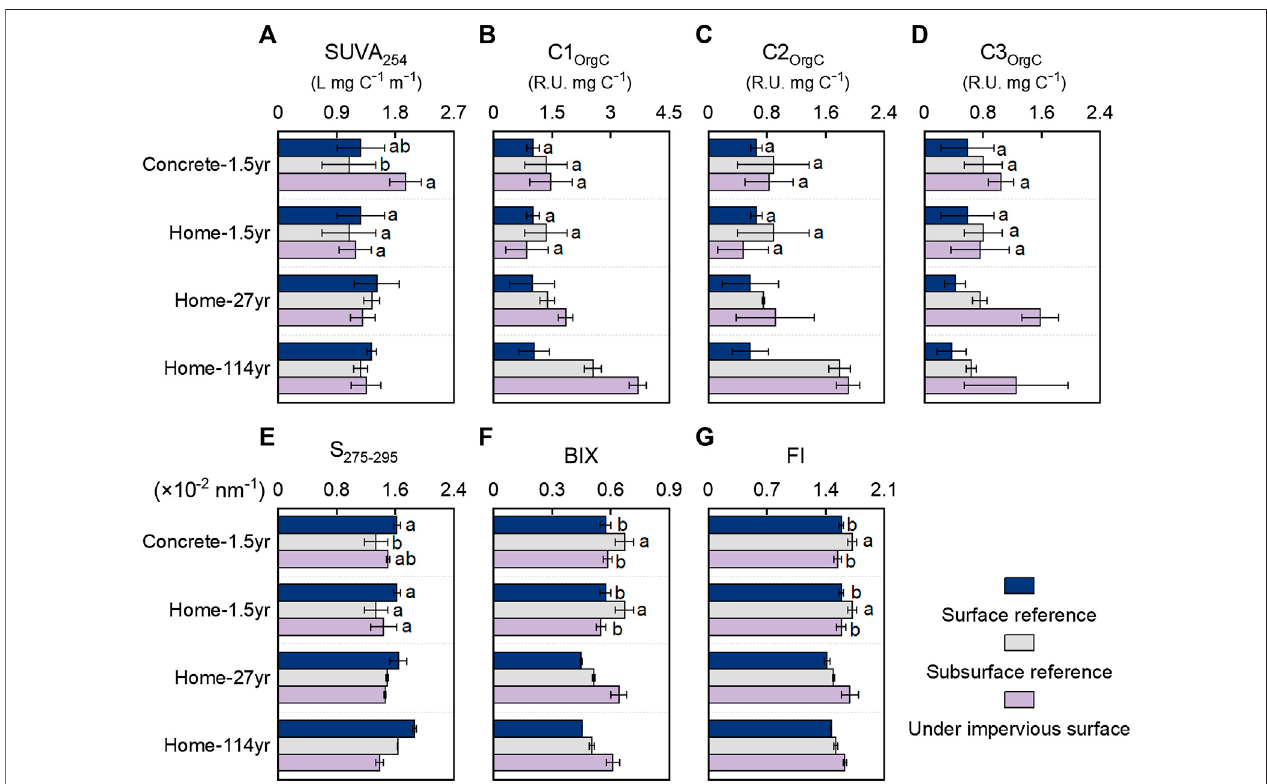
FIGURE 3 | Spectroscopic characteristics of dissolved organic matter in soils with and without coverage by impervious surfaces. (A) SUVA 254 , speci fi c ultraviolet absorbance at 254 nm; (B – D) C1 OrgC – C3 OrgC relative abundance of fl uorescent components per total dissolved organic carbon; (E) S 275 – 295 , the absorbance slope between 275 and 295 nm; (F) BIX, biological index; (G) FI, fl uorescence